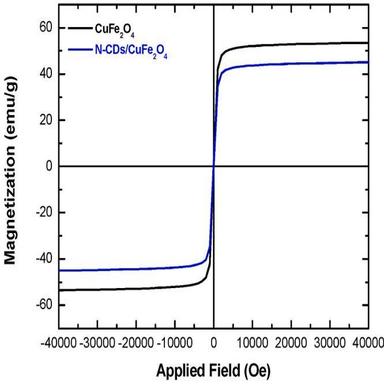
M − H measurements of CuFe2O4 and N-CDs/CuFe2O4. (A colour